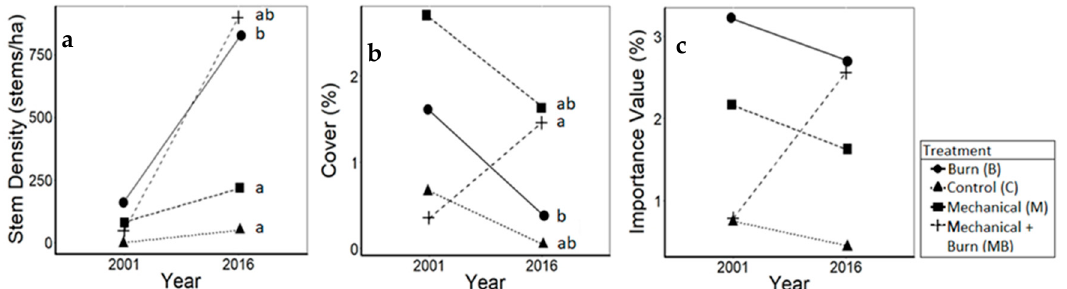
Table 3. Change in abundancy for the secondary vegetation guilds after 15 years (2001–2016) of repeated treatments (control = C, burned = B, mechanical removal of stems <10 cm in diameter at breast height (DBH) = M, and mechanical removal of stems <10 cm DBH + burned = MB). Means, standard deviations, and p ‐ values for each ANOVA are indicated in parentheses next to each guild. Lowercase letters identify the statistically different treatment effect at p < 0.05.